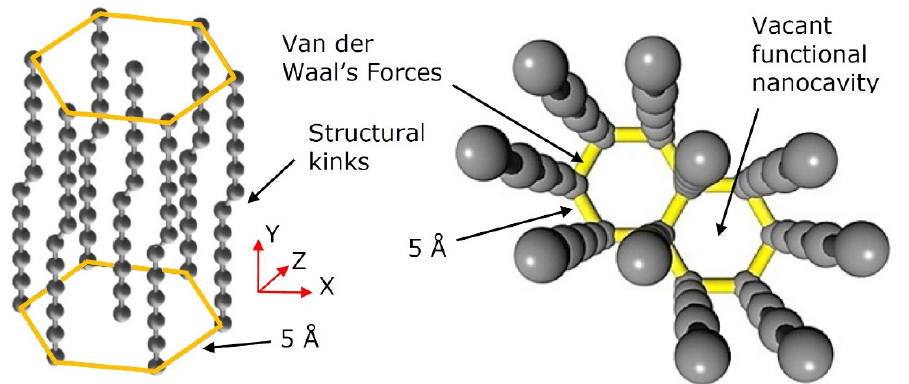
Figure 2. Spatial structure of the 2D-ordered linear-chain carbon-based nanomatrix fragment, con- taining the nanocavity, available for heteroatom doping.